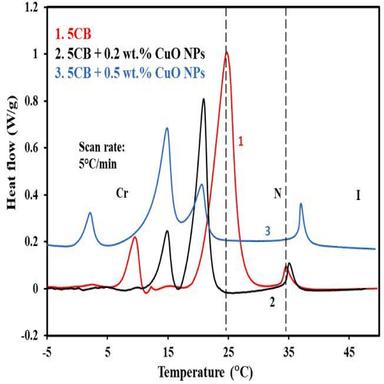
DSC thermograms for the heating cycles for pure 5CB and its nanocomposites. Broken vertical lines indicate crystal to nematic and nematic to isotropic phase transitions of pure 5CB.